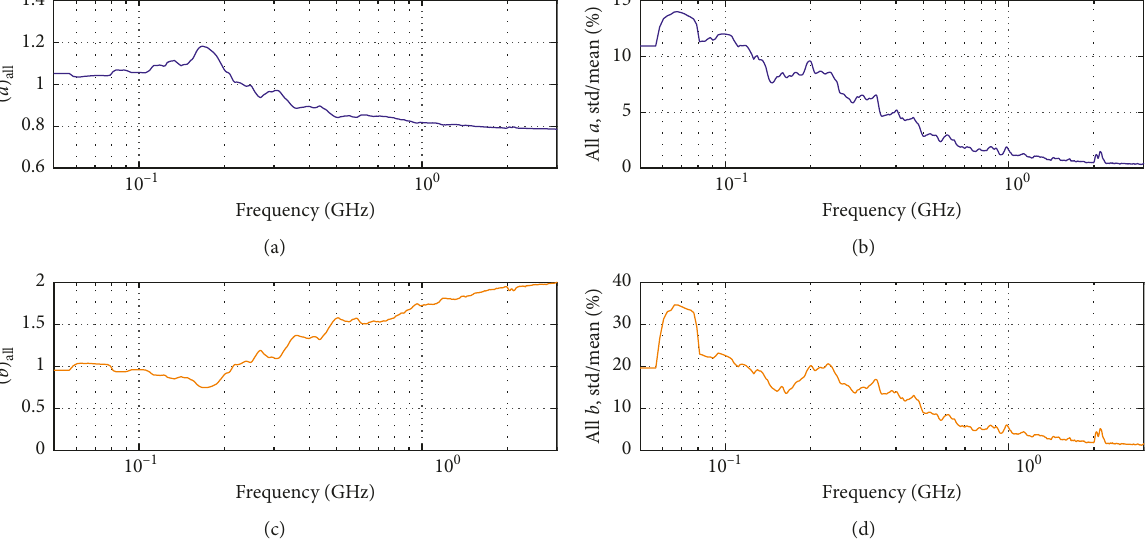
Figure 4: Mean values and the relative standard deviation (in percentage) of the estimated ( a,b ) ; values for all positions and polarizations are